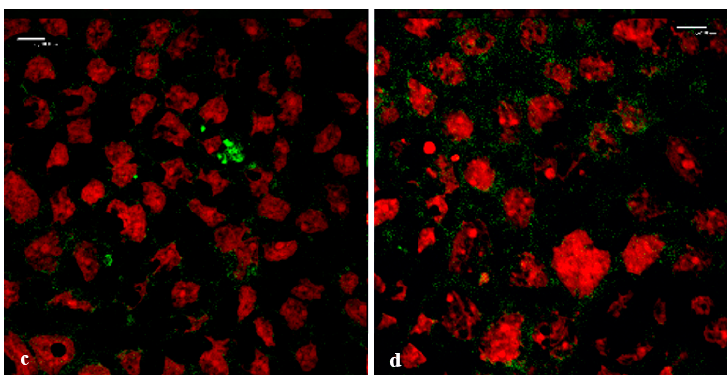
Figure 8. Top-view confocal micrograph images of the Caco-2 cell monolayers on which the FITC-dextran with MW of 4 kDa (FD-4) was applied ( green : FD-4 and red : cell nuclei stained with propidium iodide). ( a ) Negative control (FD-4 alone), ( b ) positive control (0.5% w / v TMC), ( c ) A. vera gel (1.0% w / v ), and ( d ) A. vera whole-leaf extract (1.0% w / v ) (Scale bars represents 10 µ m). From the confocal micrograph images in Figure 8, the intercellular accumulation of FD-4 (green)